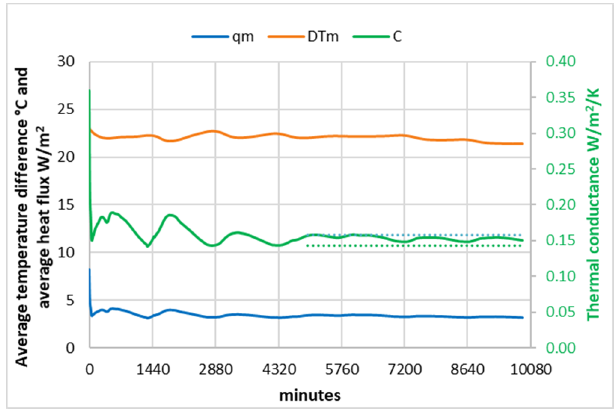
Figure 19. Casa Cembo: average heat flux, average surface temperature difference, and average thermal conductance C.